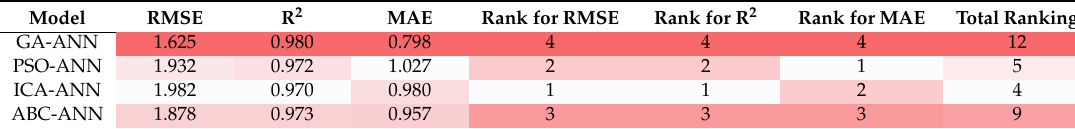
Table 3. Prediction results of the hybrid models and their performance (for the testing